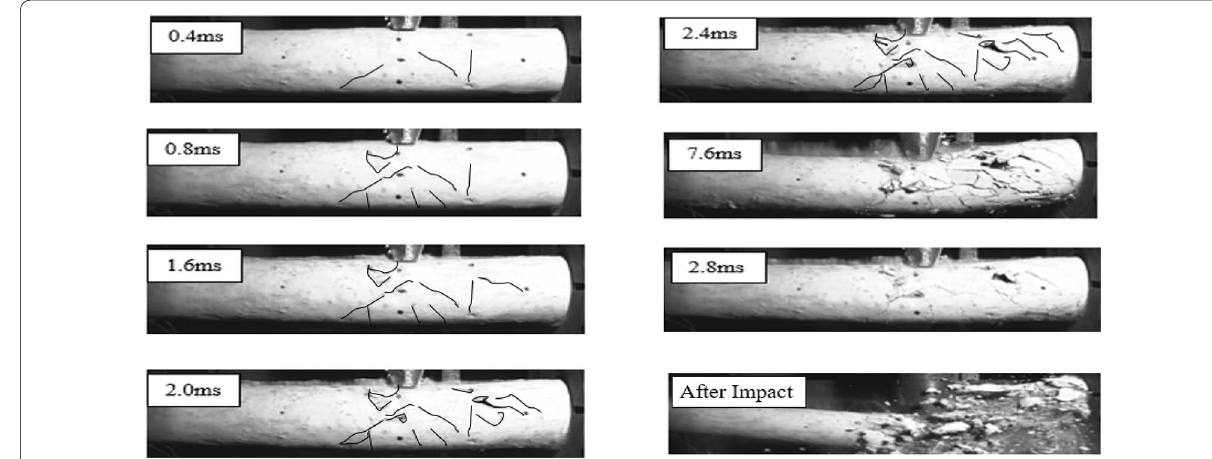
Fig. 7 YH2 crack development process.